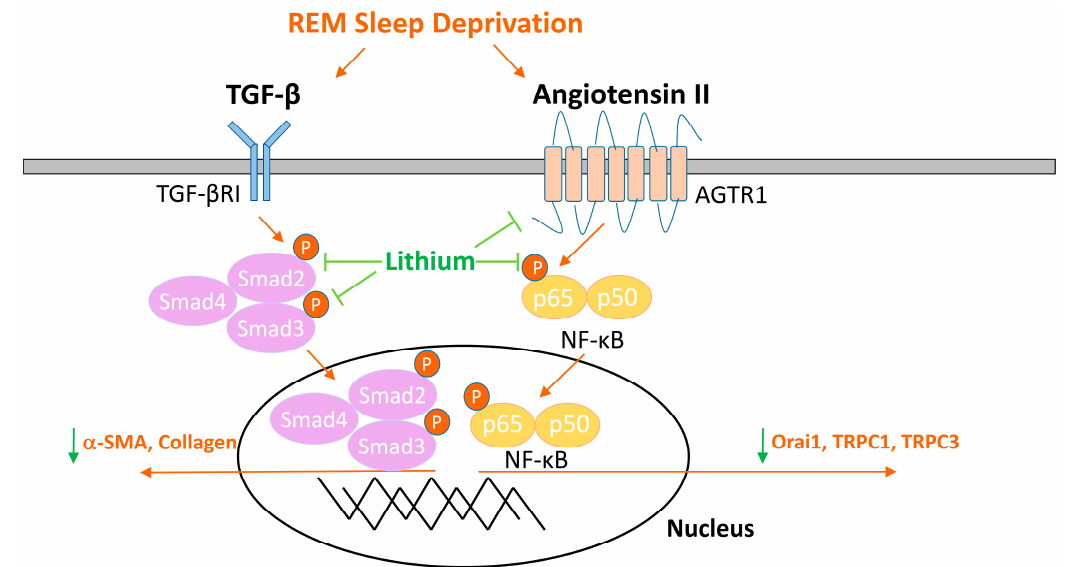
Figure 6. Schematic illustration of the proposed mechanisms for cardioprotection of lithium in REM sleep deprivation. Lithium may improve ventricular dysfunction and cardiac fibrosis in REM sleep- deprived hearts via the downregulation of the transforming growth factor beta signaling pathway, angiotensin II cascade, and store-operated Ca 2+ entry. Abbreviations: α -SMA = α -smooth muscle actin; AGTR1 = angiotensin II receptor type 1; NF- κ B = nuclear factor kappa B; Orai1 = calcium release-activated calcium channel protein 1; REM = rapid eye movement; TGF- β = transforming growth factor beta; TGF- β R1 = transforming growth factor beta receptor 1; TRPC1 = transient receptor potential canonical 1 channel; TRPC3 = transient receptor potential canonical 1